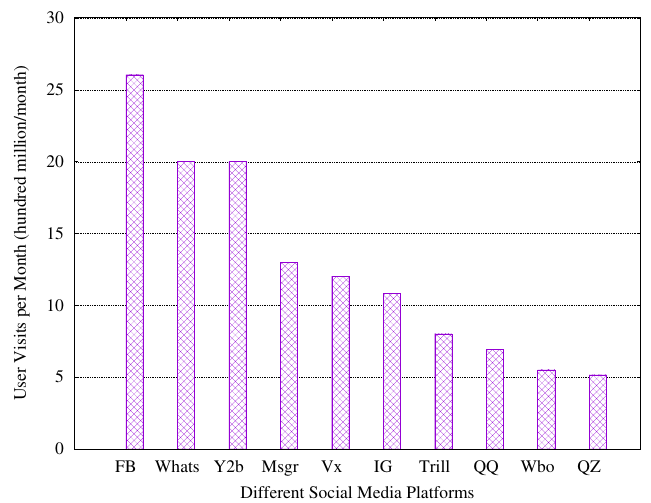
Figure 1. Monthly user visits of different social media